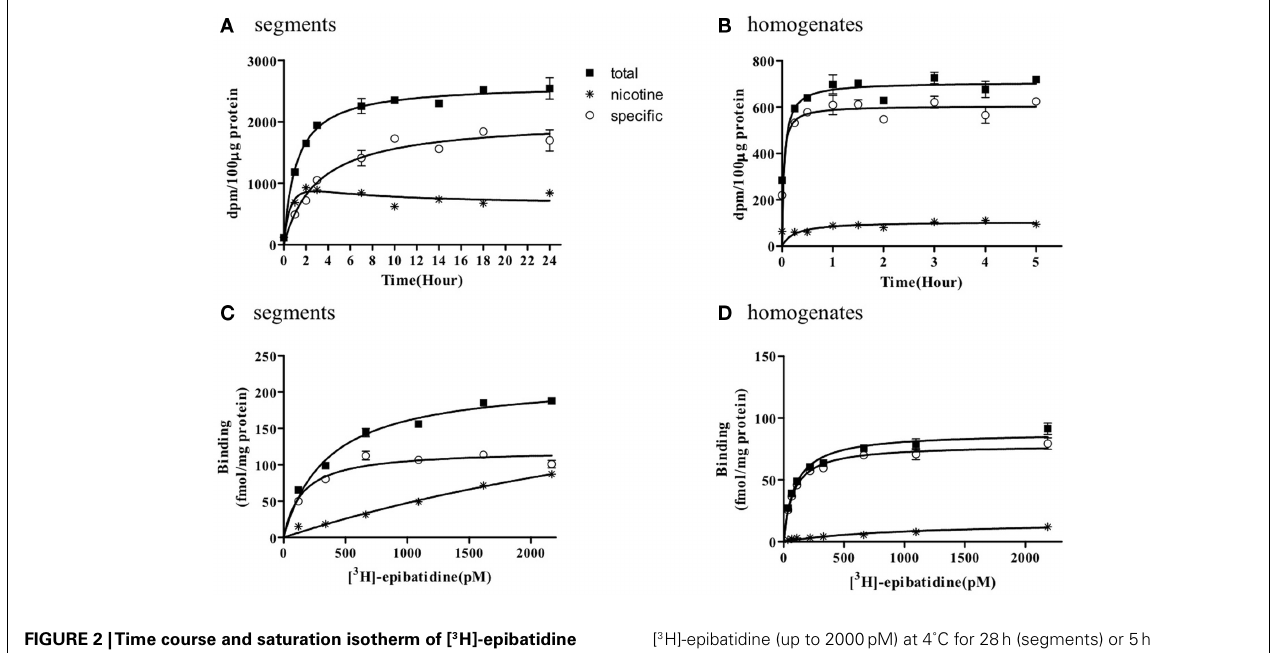
[ 3 H]-epibatidine (up to 2000pM) at 4˚C for 28h (segments) or 5h (homogenates). Specific binding (open circles) was determined by subtracting the amount bound in the presence of 100 μ M nicotine (asterisks) from total binding (closed squares). Each point represents the mean of duplicate determinations. Each figure represents four to five experiments.